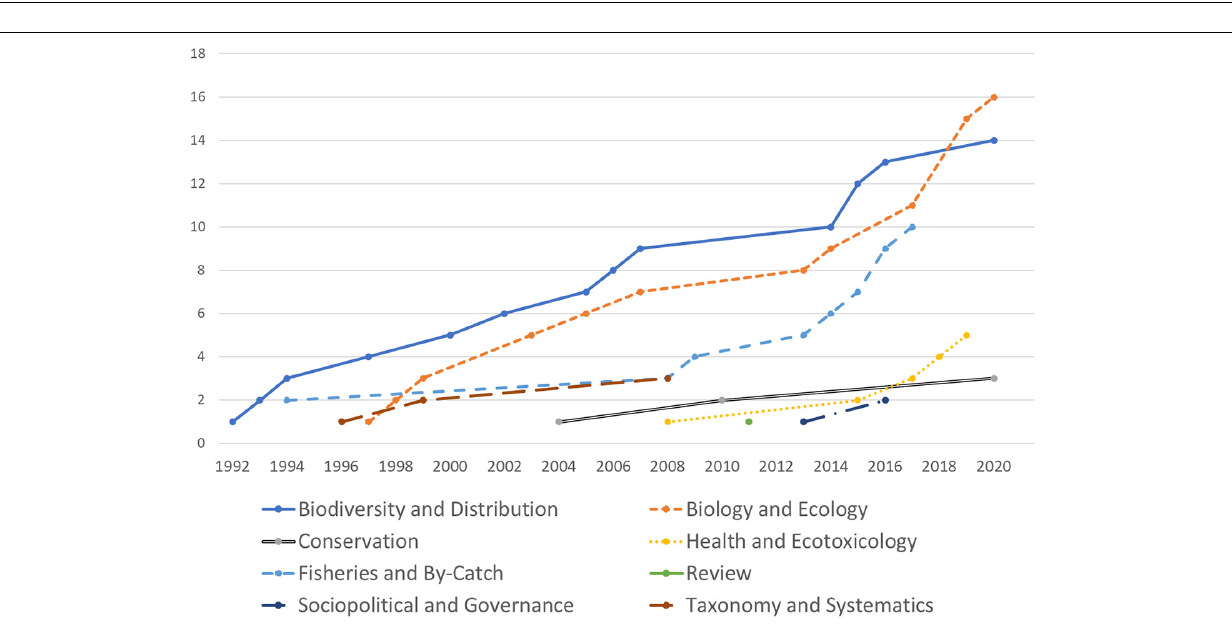
FIGURE 2 | Cumulative number of marine mammal research in the Philippines from 1991 to 2020 based on peer-reviewed journal articles and conference